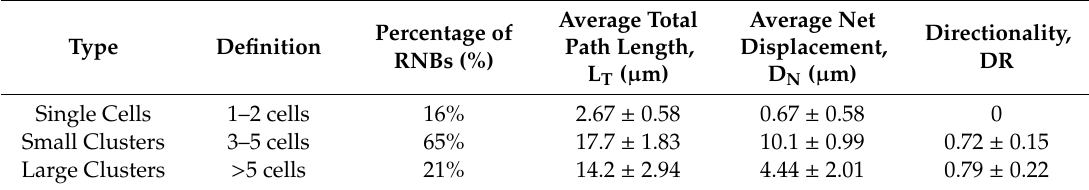
Table 2. Migration and directionality of small RNB clusters in control conditions (Schneider’s medium, only) and in response to targeted FGF concentration profiles within a µ OS device over the 8-h experimental time